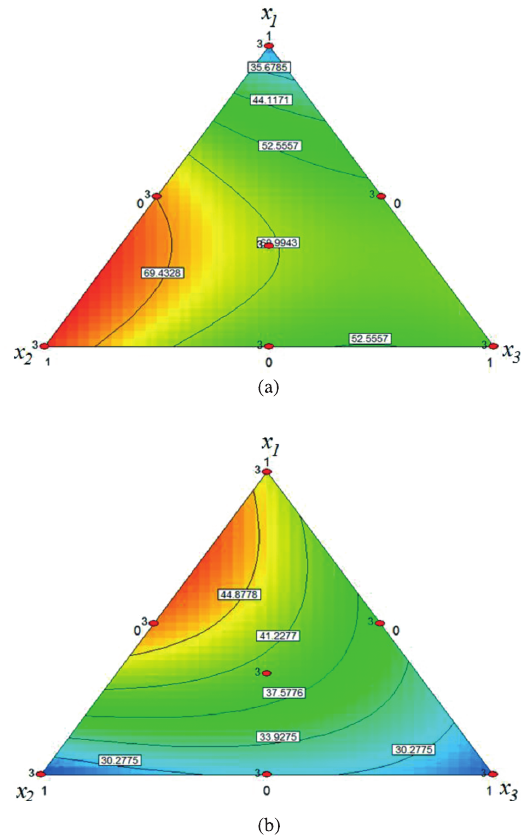
Figure 4. Response surface of the region of combination of variables x , x and x obtained with Equations 2 and 3 for (a) degree of 1 2 3 conversion, (b) Vickers